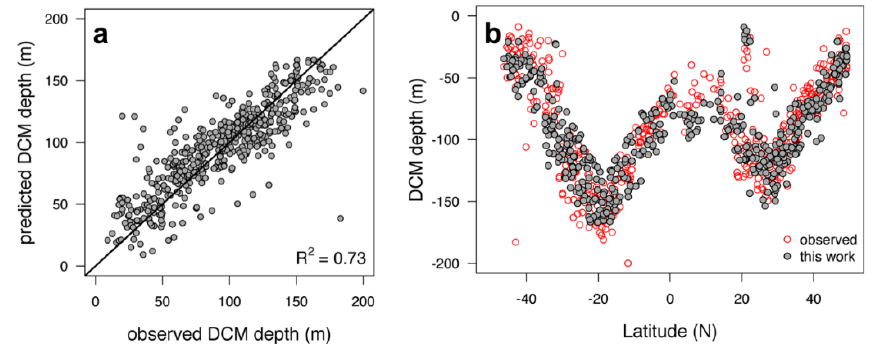
Figure 4. ( a ) Comparison between observed versus predicted depth of the deep chlorophyll maximum ( Z DCM ) across the Atlantic Ocean (locations displayed in Figure 1) using Equation (8) of the present work; ( b ) Observed (AMT12-24, n = 693 observations) and predicted Z DCM ( n = 449) in the Atlantic Ocean (AMTs 12 to 24, locations displayed in Figure 1). For each CTD cast, observed Z DCM was determined as the depth of the maximum chlorophyll concentration measured using the CTD fluorometer.